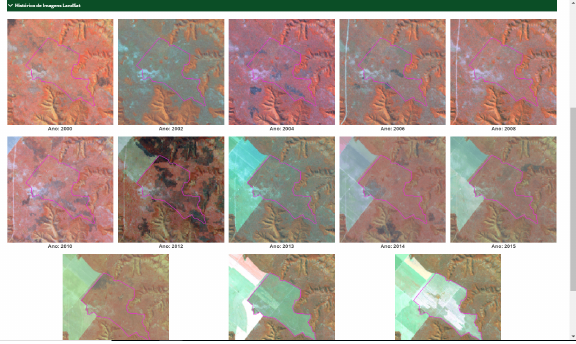
Figure 11. Deforestation Report presenting all the historical Landsat Images from 2000 until 2018 (which were used in the sampling validation).